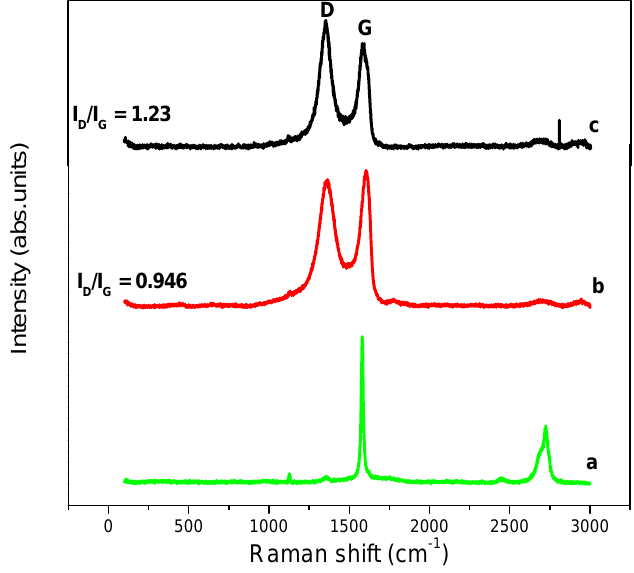
Figure 3. Raman spectra of graphite (curve a ), graphite oxide (curve b ) and graphene (curve c